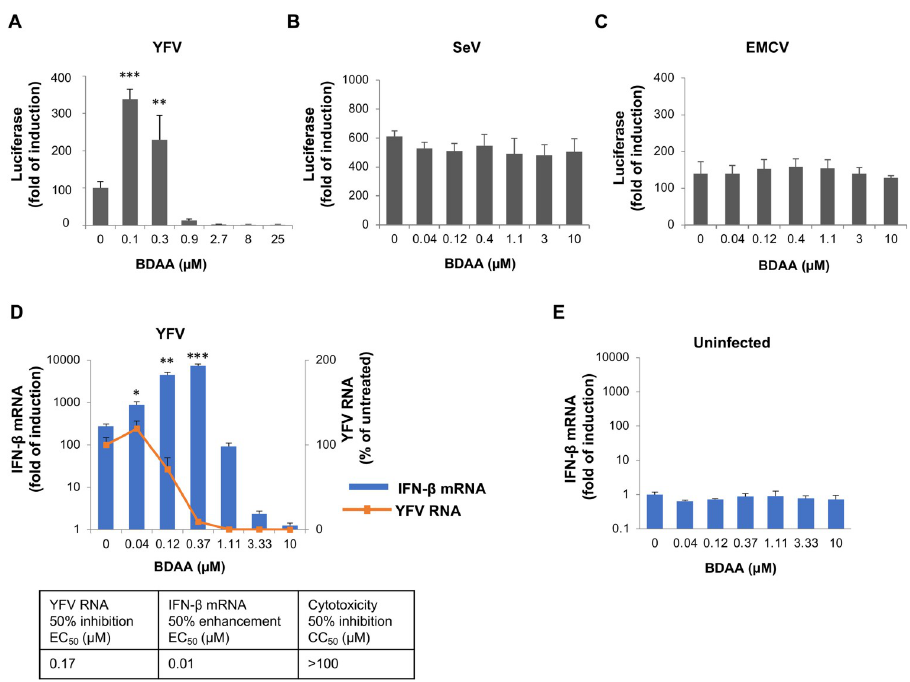
Fig 1. BDAA treatment specifically enhances YFV-induced IFN- β expression. (A to C) Effect on reporter expression in 293/IFN β Luc cells expressing luciferase under IFN- β promotor control. 293/IFN β Luc cells were seeded on 96-well plate and infected with YFV at MOI of 0.01 (A), Sendai virus (Sev) at 40 HAU (B), or encephalomyocarditis virus (EMCV) at MOI of 0.01 (C) for 1 h, followed by treatment with indicated concentration of BDAA. Luciferase activity was detected at 48 hpi and expressed as fold of induction relative to that in uninfected cells. Values represent average and standard deviation (STDV) from 3 independent experiments. (D to E) Effect on YFV RNA and IFN- β mRNA expression in 293/IFN β Luc cells. 293/IFN β Luc cells were either infected with YFV at MOI of 0.01 (D), or mock infected (E), for 1 h followed by treatment with indicated concentration of BDAA. Total cellular RNA was extracted at 48 hpi to detect YFV RNA and/or IFN- β mRNA by qRT-PCR. YFV RNA was expressed as percentage of YFV-infected and untreated control (D). IFN- β mRNA was expressed as fold of induction relative to that in uninfected cells (D) or untreated cells (E). BDAA concentrations for 50% inhibition of YFV RNA and 50% enhancement of IFN- β mRNA were calculated based on corresponding dose-responsive curves using GraphPad Prism 7. BDAA concentration for 50% inhibition of cell viability was determined by MTT assay (Sigma). Values represent average and standard deviation from 3 independent experiments. � indicates P < 0.05, �� indicates P < 0.01, ��� indicates P < 0.001 (IFN- β enhancement relative to no treatment